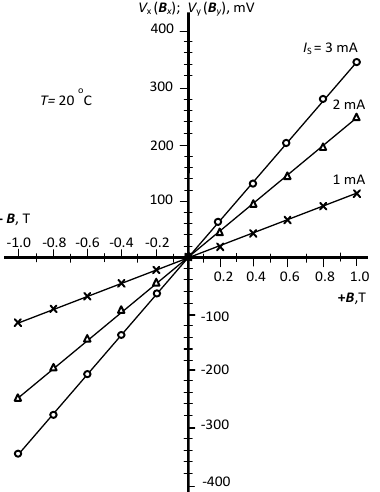
Figure 2. Output characteristics for the V x ( B ) channel of the new 2D device. The obtained magnetosensitivities are equal.